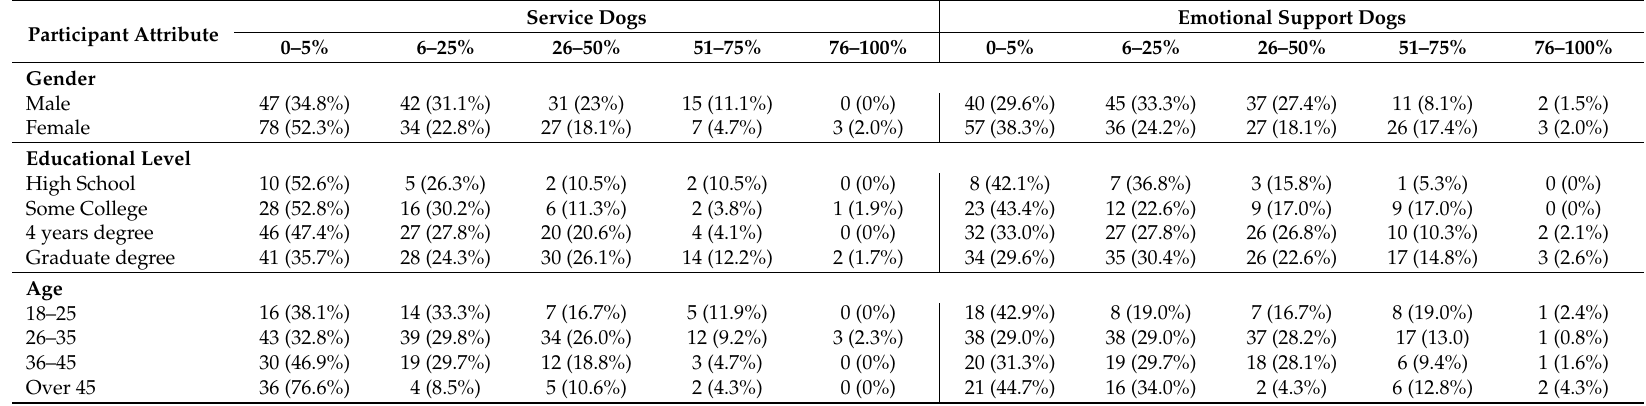
Table 6. Relationship of participants’ demographic characteristics with perceived prevalence of assistance animal misrepresentation, as assessed by the question “what percentage of people with a service dog/emotional support animal do you feel are just taking advantage of the system”.